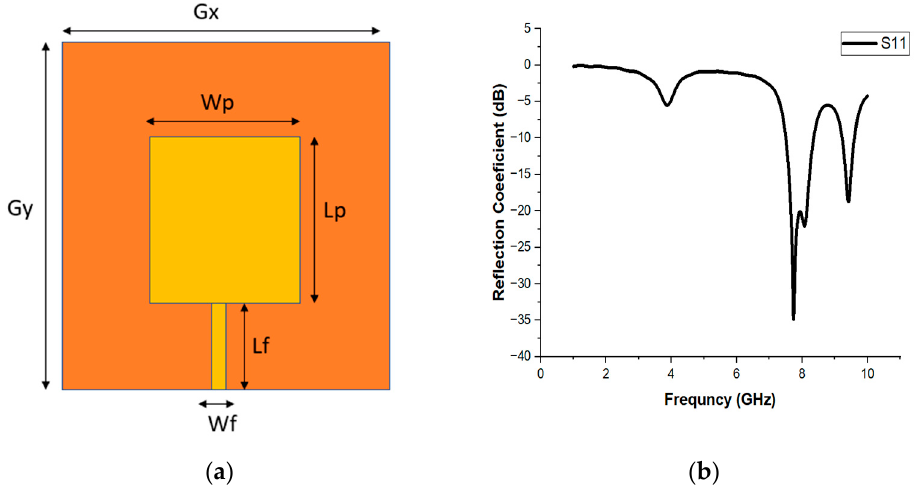
Figure 2. ( a ) Rectangular patch antenna design; ( b ) Return loss plot. Table 1. Dimensions of rectangular